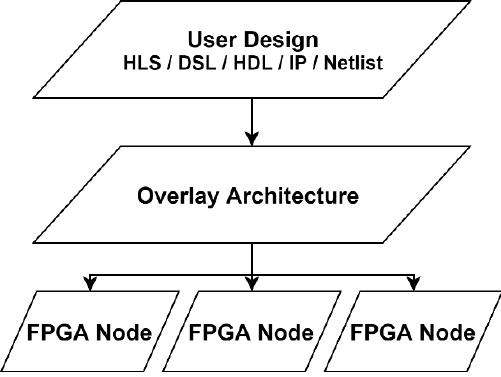
Figure 2. Generic Overlay Architecture.